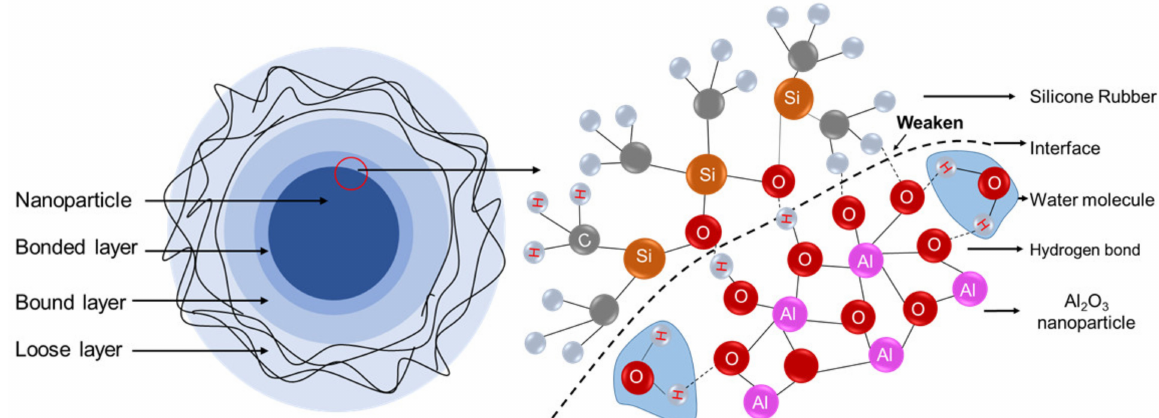
Figure 10. Interface of nanoparticles and